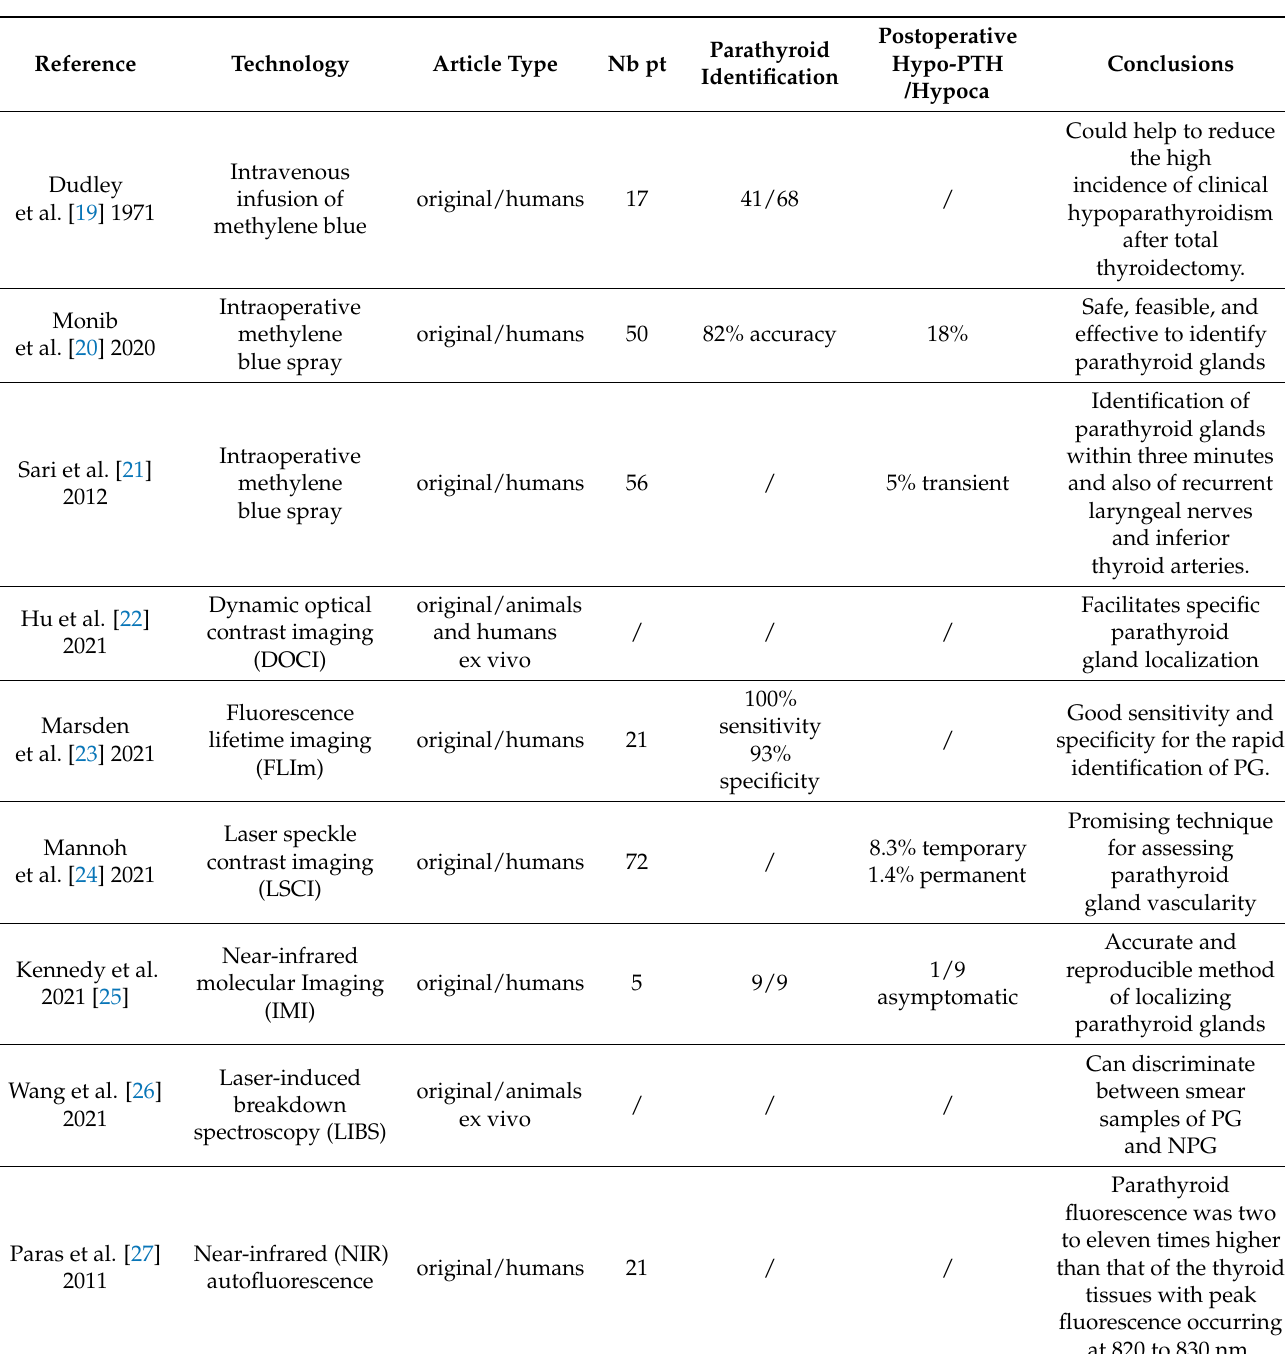
Table 2. The main original studies evaluating technologies in order to avoid postoperative hypoparathyroidism, from 1971 to